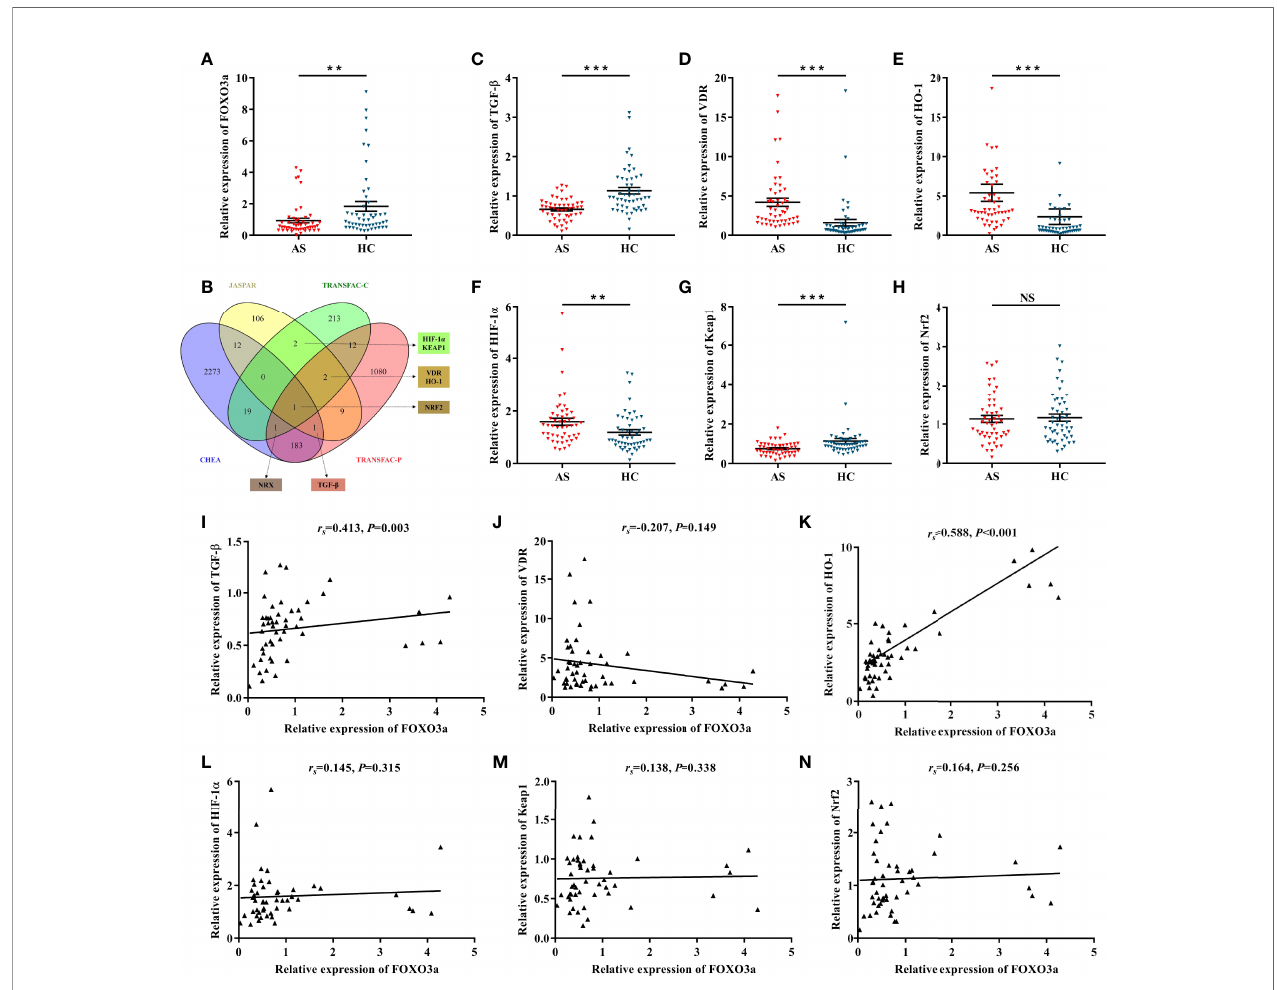
FIGURE 1 | Determination of candidate genes and the correlation with FOXO3a. (A) Relative expression of FOXO3a between AS (n = 50) and HC (n = 50). (B) Predicting FOXO3a downstream target genes in different transcription factor datasets. Nucleoredoxin (NRX) was excluded because there is no evidence that it may be associated with AS and other autoimmune diseases. (C – H) Relative expression of TGF- b (C) , VDR (D) , HO-1 (E) , HIF-1 a (F) , Keap1 (G) , and Nrf2 (H) between AS and HC. (I – N) Correlation analysis between FOXO3a and TGF- b (I) , VDR (J) , HO-1 (K) , HIF-1 a (L) , Keap1 (M) , and Nrf2 (N) in AS. All data were expressed as mean ± SEM . The differences between AS and HC were analyzed using Mann-Whitney U test. The correlation was analyzed using spearman rank correlation. ** P < 0.01, *** P < 0.001; NS, not signi fi cant versus HC group. AS, ankylosing spondylitis; HC, healthy control; r s , Spearman ’ s rank correlation coef fi cient.